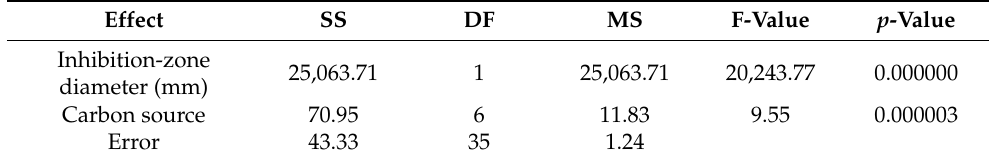
Table 2. One-way ANOVA of inhibition-zone diameters obtained by testing antagonistic activity of the cultivation broth samples against the aflatoxigenic isolates in the carbon source selection investigation step.